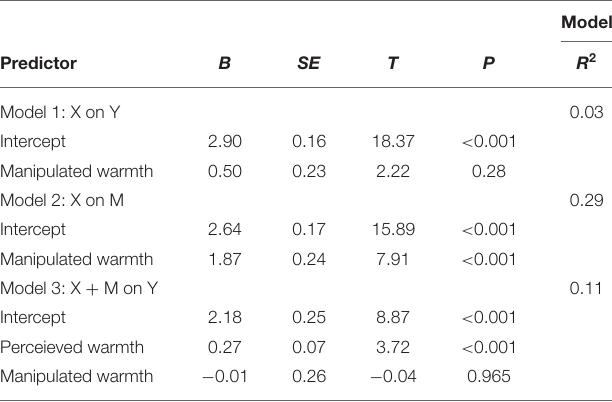
TABLE 8 | Mediated regression analysis testing the effect of manipulated warmth on anticipated trust mediated by perceived warmth in study 2. Predictor